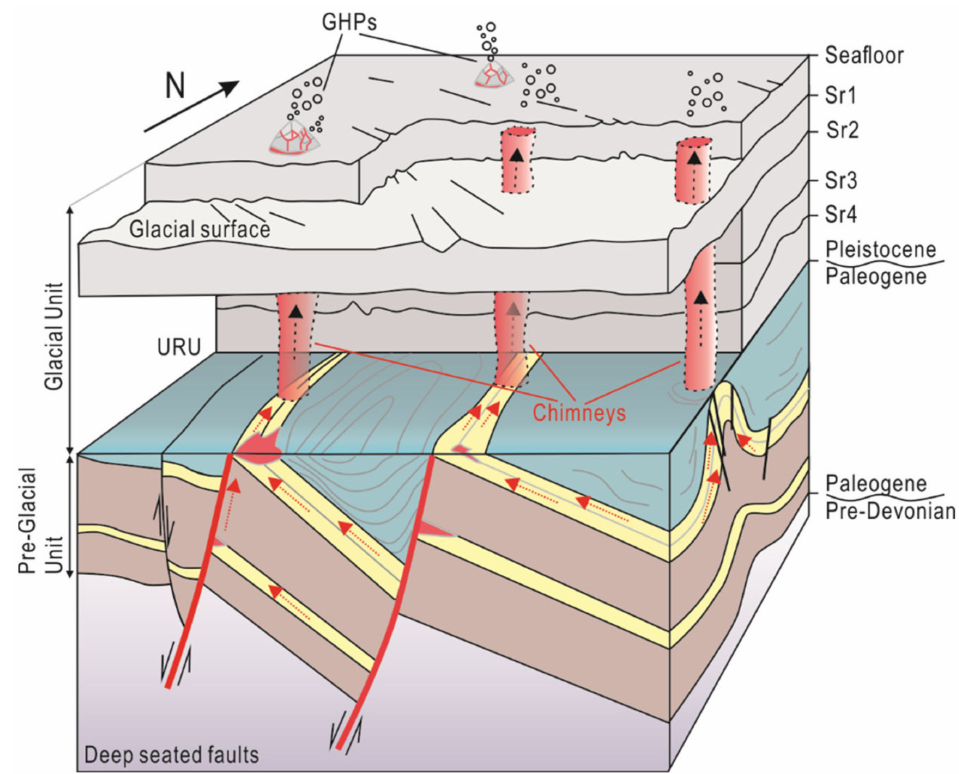
Figure 7. Fluid flow concept model and the chimney-type hydrate system of the Storfjordrenna GHP site. Deep-sourced gas flows through deep-seated faults and inclined bedding, and then through subvertical gas chimneys embedded in the low-permeable glacial rocks. Due to hydrate growth, shallow sediments lose bulk density and expand, creating hydrate pingoes beneath the seafloor. Note: GHPs: Gas hydrate pingoes; URU: Upper regional unconformity (cited from